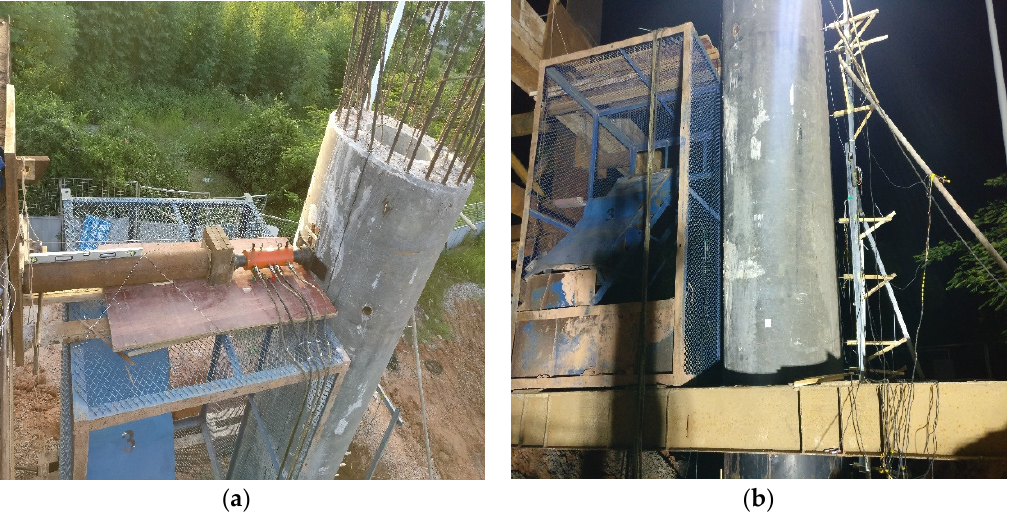
Figure 10. Field test of horizontal static load test of the single pile: ( a ) ballast platform and lifting jack and ( b ) displacement sensor installation.